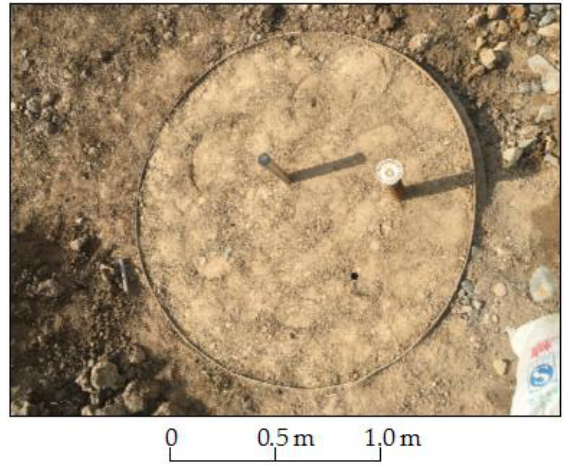
Figure 6. Reclaimed soil after one-compaction test barrel.